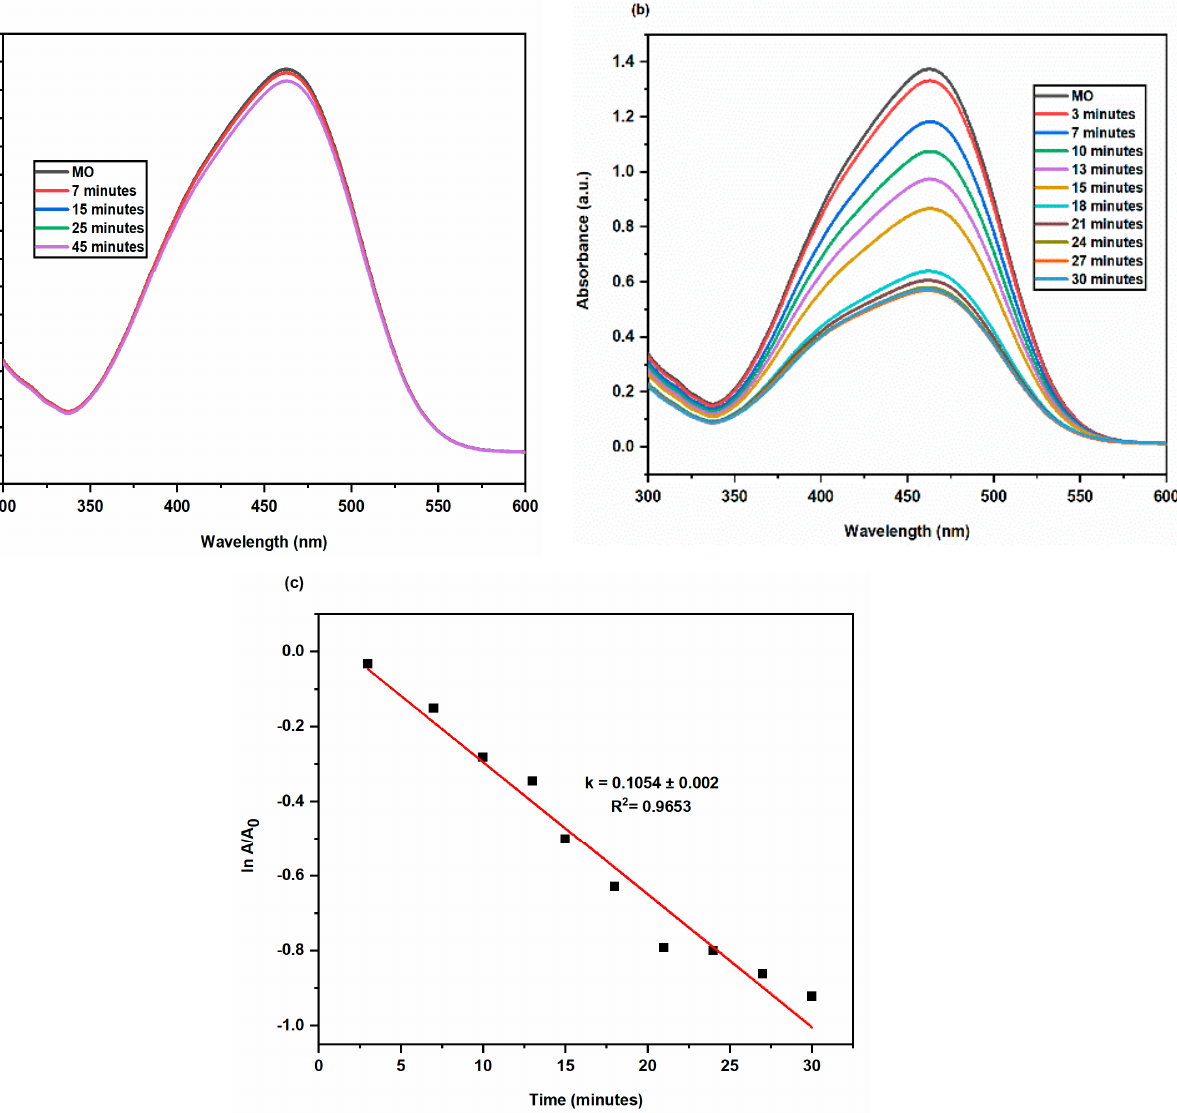
Figure 11. At 25 ◦ C, successive UV–Vis absorbance spectra showing reduction of MO by NaBH 4 ( a ) reaction mixture without AgNPs ( b ) reaction mixture containing 100 µ L of AgNPs ( c ) Smooth plots of ln A/A 0 versus time for the degradation of MO at 25 ◦